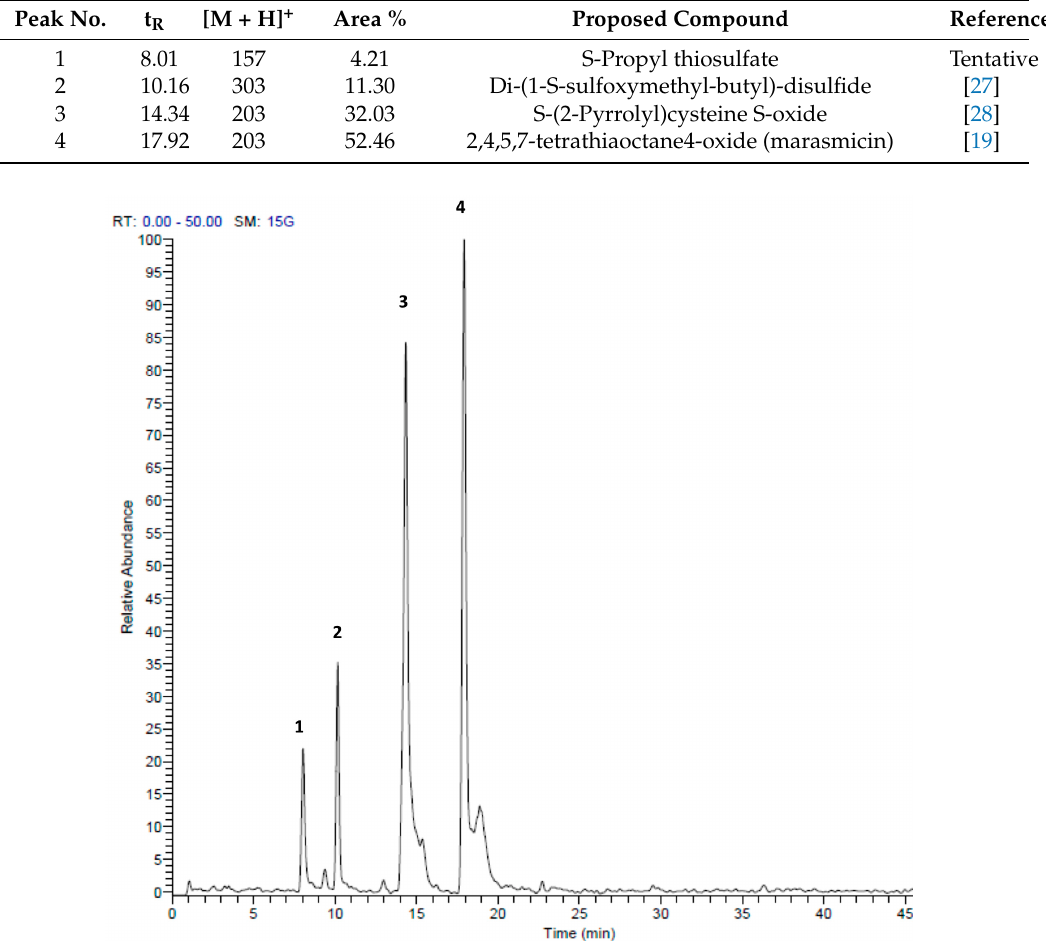
Figure 3. HPLC-MS/MS profile of Tulbaghia violacea extract in the positive mode (+). Peak retention times correspond to compounds listed in Table 2.